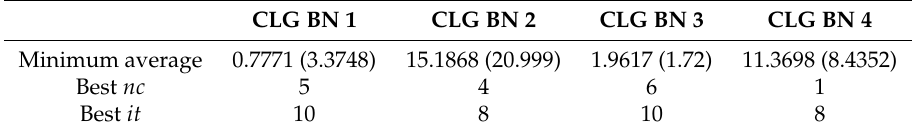
Table 4. Minimum averages for Kullback Leibler (KL)-divergences and best values for nc and it